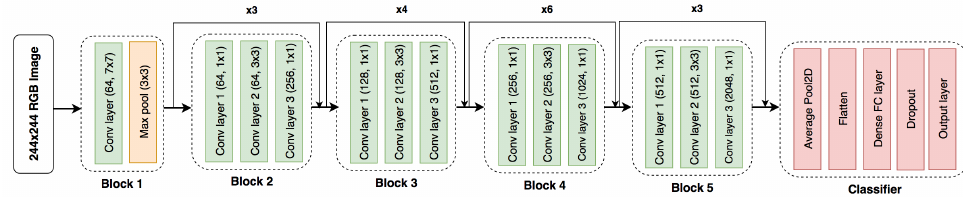
Figure 5. Illustration of ResNet-50V2 network architecture.